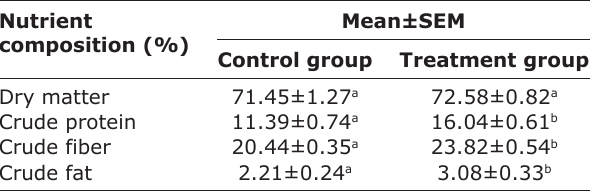
Table-3: Nutrient composition of feed formulation in control and treatment